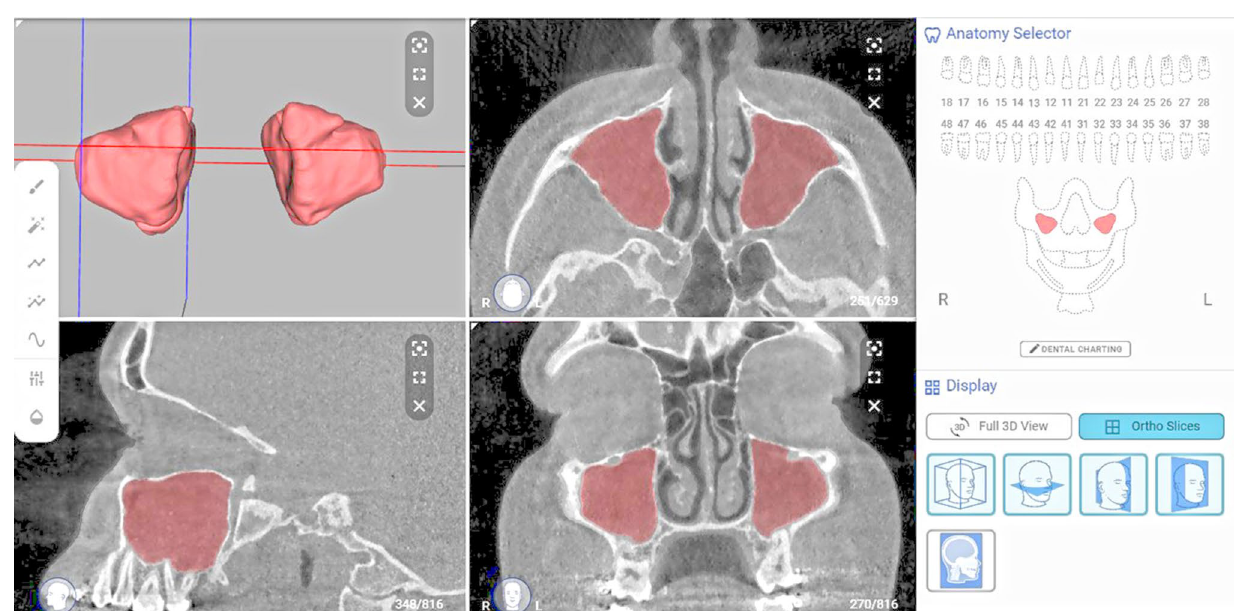
Figure 3. The resultant automatic segmentation on virtual patient creator online platform (creator.relu.eu, Relu BV, Version October